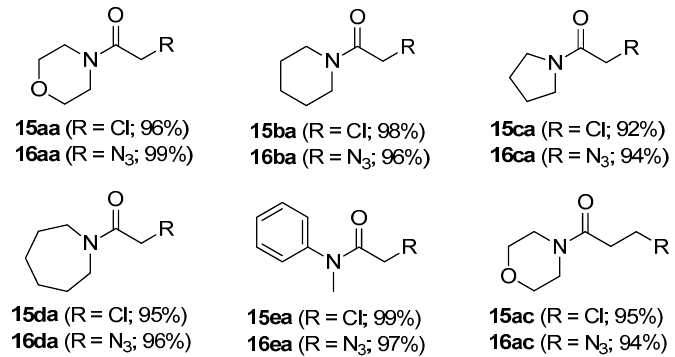
Figure 7. Prepared tertiary amides 15 and sodium azidoamide 16 .